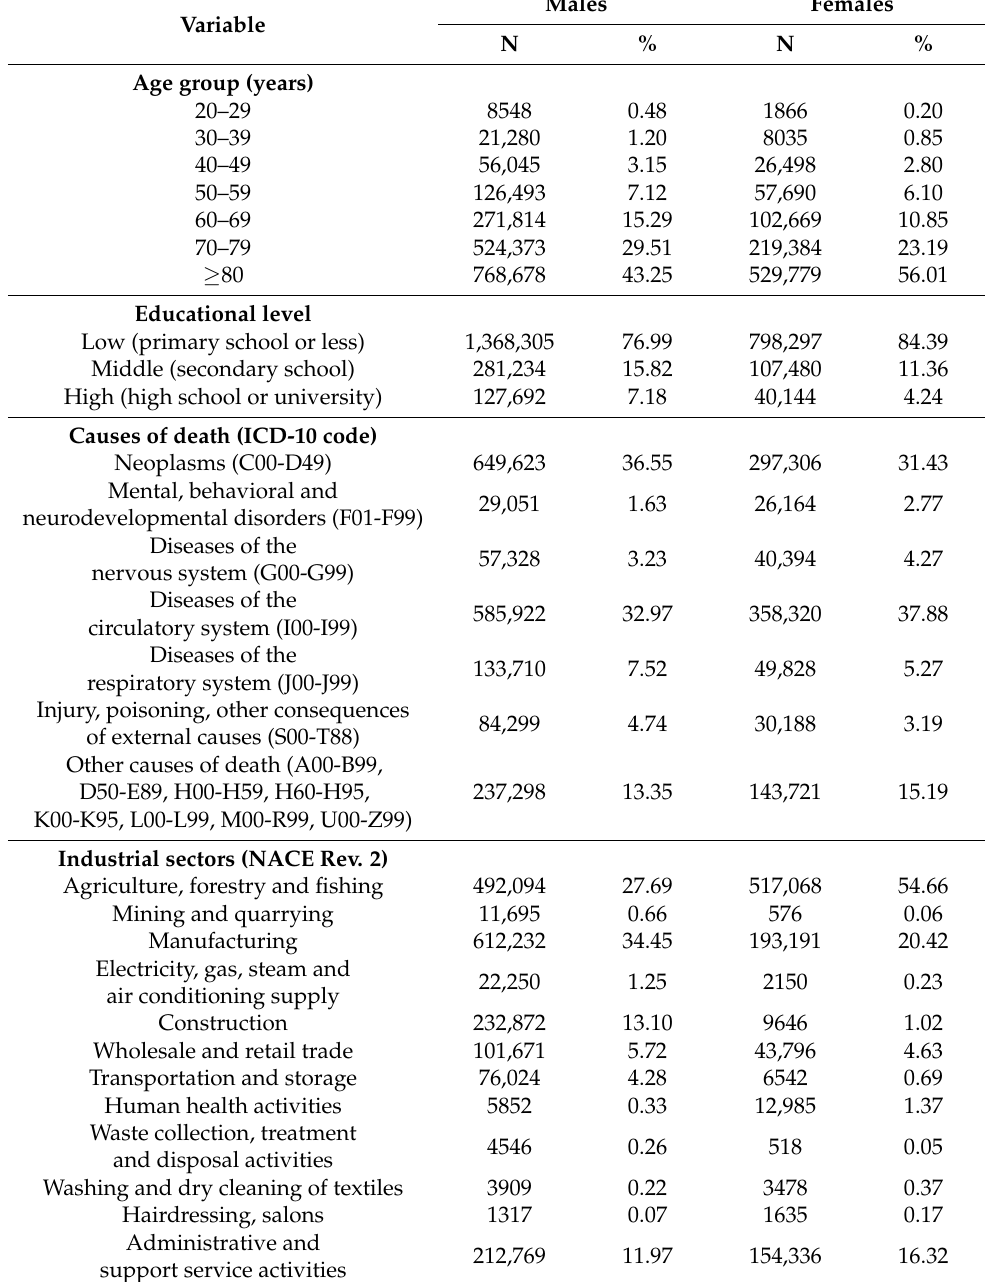
Table 1. Descriptive data of integrated archive resulting from the record linkage between mortality and occupational data by gender (N = 2,723,152; period: